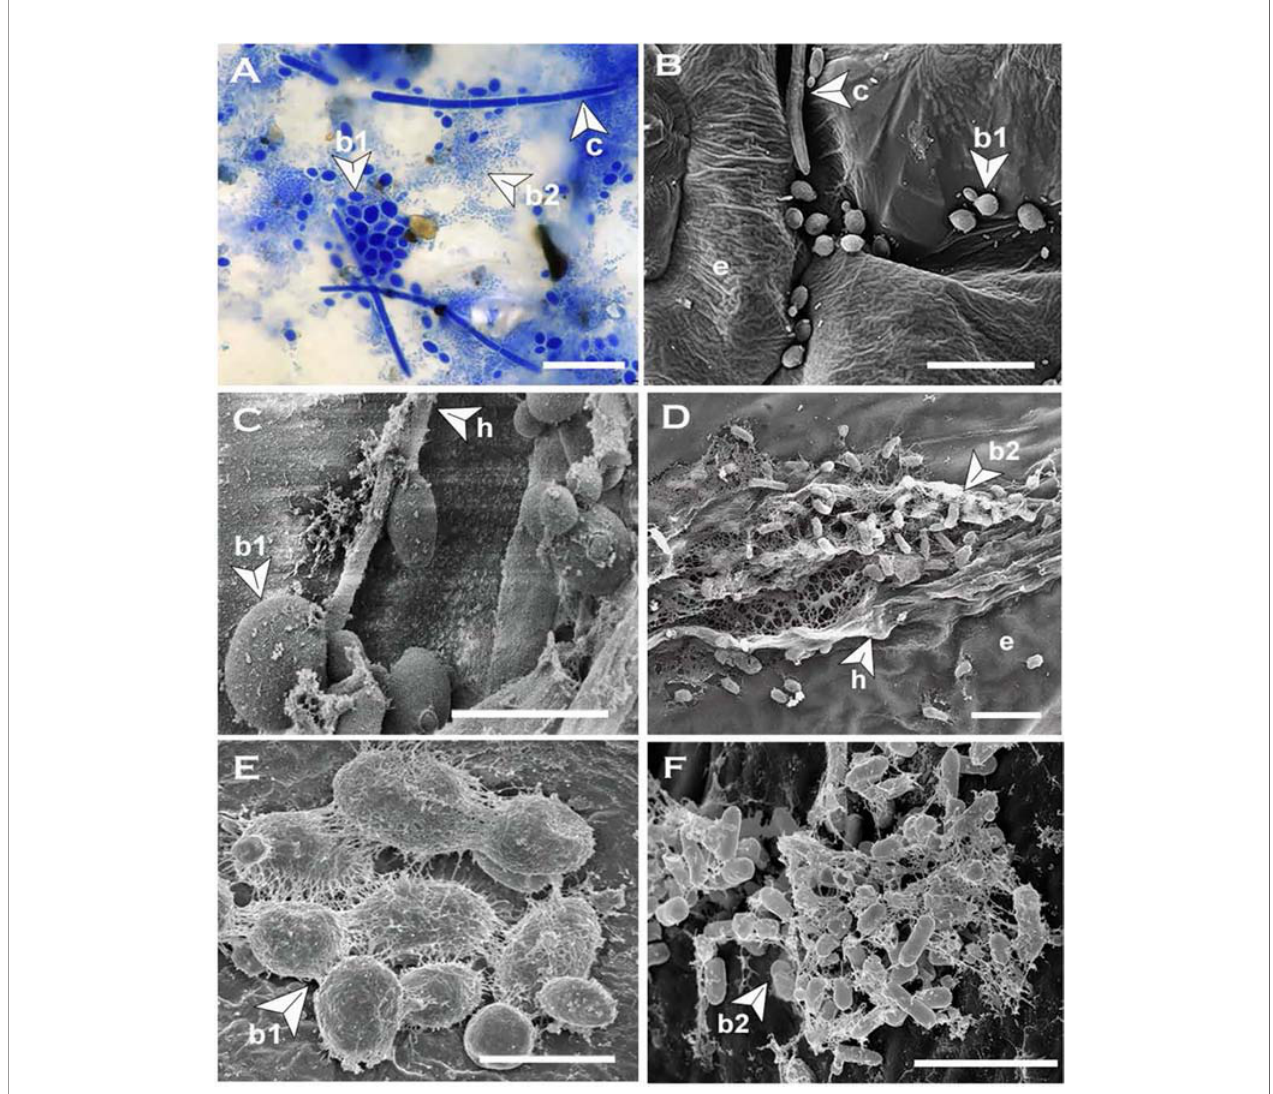
FIGURE 7 | Blastospores produced by Neopseudocercosporella capsellae on cotyledons of the host Brassica juncea or B. napus. (A) Multi-celled macroconidia (c), meso-blastospores (b1) and micro-blastospores (b2) on a cotyledon surface 48h post-inoculation with a multi-celled macroconidial suspension (cotyledons were decolorized by immersing in acetic acid:ethanol:water (2:2:1) solution at 25°C for 3-4 days before visualization under the light microscope (scale bar= 20µm). (B) Cotyledon surface inoculated with a multi-celled macroconidial suspension showing multi-celled macroconidia (c), meso-blastospores (b1), and epidermal cells (e) as seen under Scanning Electron Microscope (SEM) (Scale bar=10µm). (C, D) Cotyledon surface inoculated with hyphal fragments showing hyphae (h) producing meso-blastospores (C) (Scale bar=5µm) and micro-blastospores (D) (Scale bar=1µm) as seen under SEM. (E, F) Morphology of meso-blastospores (E) (Scale bar=5µm) and micro-blastospores (F) (Scale bar=1µm) produced in planta as seen under